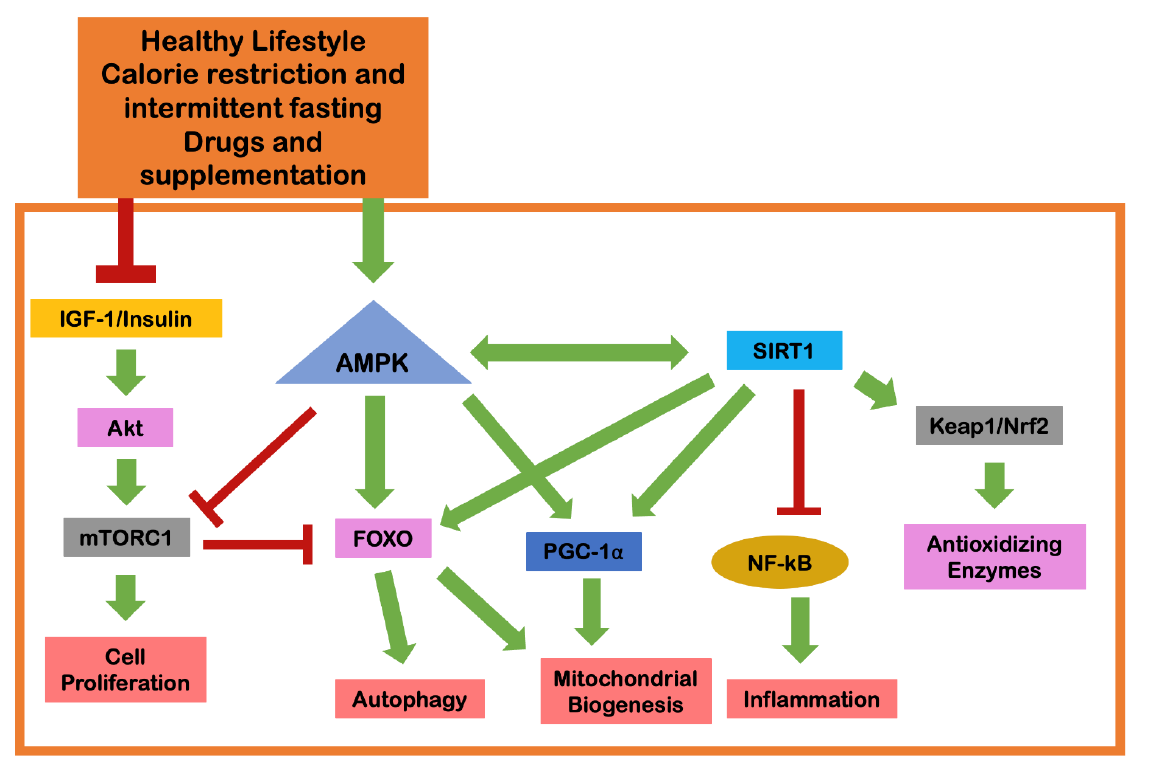
Figure 2. Molecular interactions that underlie the benefits of lifestyle, calorie restriction, intermittent fasting, drugs and supplements in geroprotection (adapted from Russo et al. [12]). The red bars in the figure indicate the inhibitory capacity of the molecular elements, while the green arrows refer to the capacity for stimulatory action. Abbreviations: Akt, protein kinase B; AMPK, 5'adenosine monophosphate-activated protein kinase; FOXO, forkhead box O; IGF-1, insulin-like growth factor 1; Keap1/Nrf2, Kelch-like ECH-associated protein 1/ nuclear factor-erythroid 2-related factor 2; mTORC1, mechanistic target of rapamycin complex 1; NF-kB, nuclear factor kappa B; PGC-1 α , peroxisome proliferator-activated receptor gamma coactivator-1 alpha; SIRT1, sirtuin